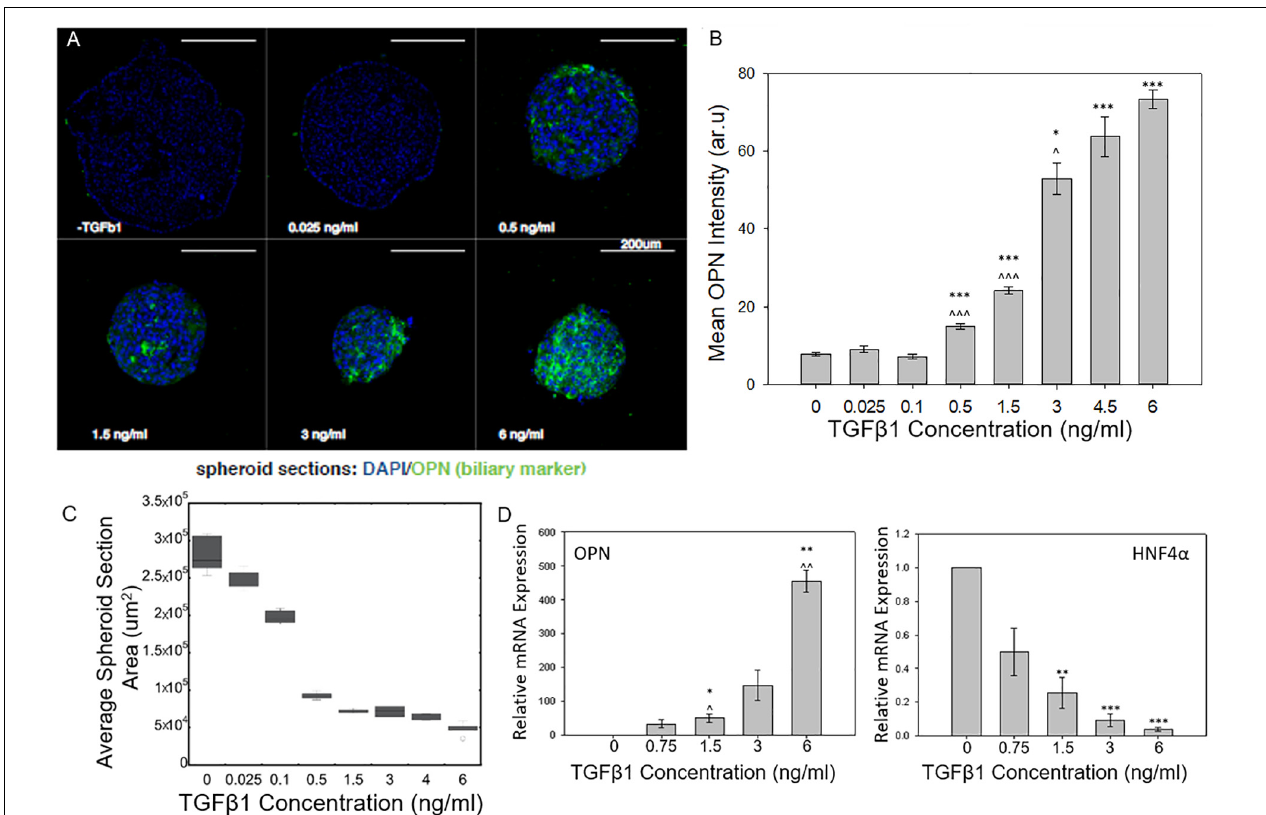
FIGURE 1 | TGF β 1-mediated differentiation of liver progenitor cell spheroids. (A) Cross sections of BMEL spheroids immunostained for OPN with increasing TGF β 1 dosage. (B) Mean OPN intensity of BMEL spheroids increased as TGF β 1 concentration is increased. Student t -tests were performed both against 0 ng/ml TGF β 1 (* P < 0.05; *** P < 0.001) and against the next lowest TGF β 1 concentration (ˆ P < 0.05; ˆˆˆ P < 0.001). (C) An increase in TGF β 1 concentration leads to a decrease in spheroid cross-sectional area (D) Relative mRNA expression of OPN and HNF4a against TGF β 1 concentration. (* P < 0.05; *** P < 0.001 compared to 0 ng/ml TGF β 1 and ˆ P < 0.05; ˆˆ P < 0.01 compared to next lowest TGF β 1 concentration).